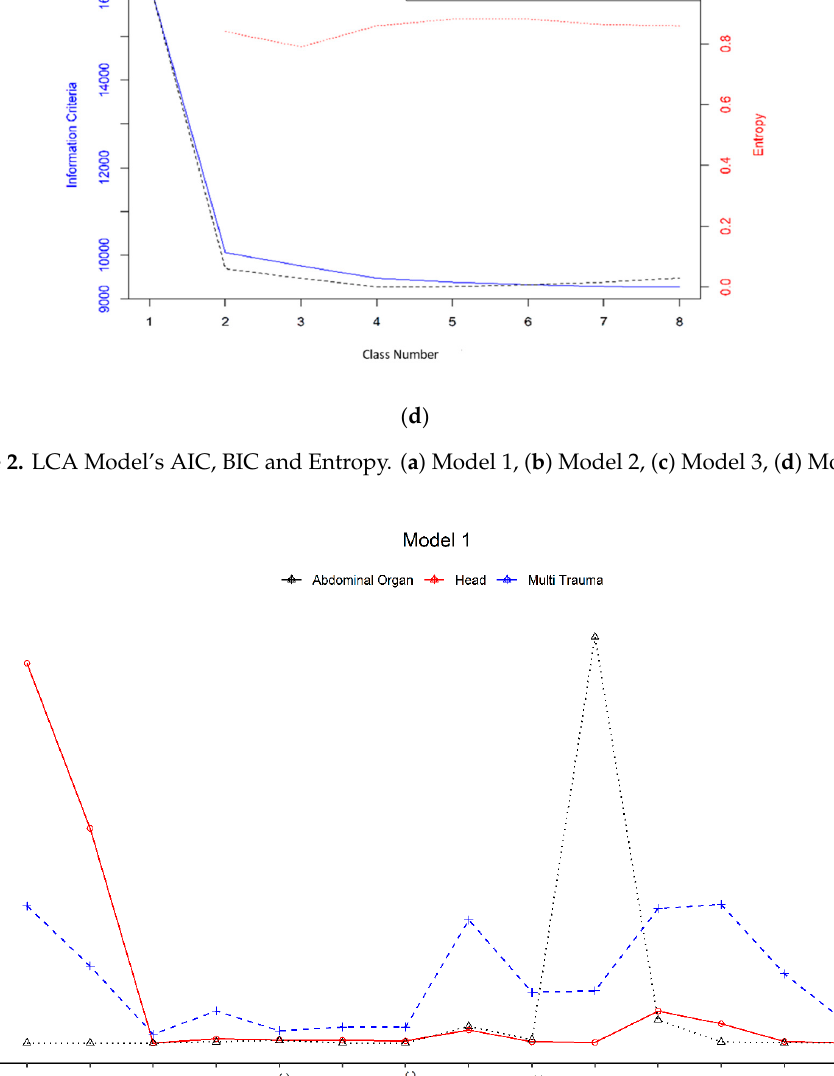
Figure 2. LCA Model’s AIC, BIC and Entropy. ( a ) Model 1, ( b ) Model 2, ( c ) Model 3, ( d ) Model 4.